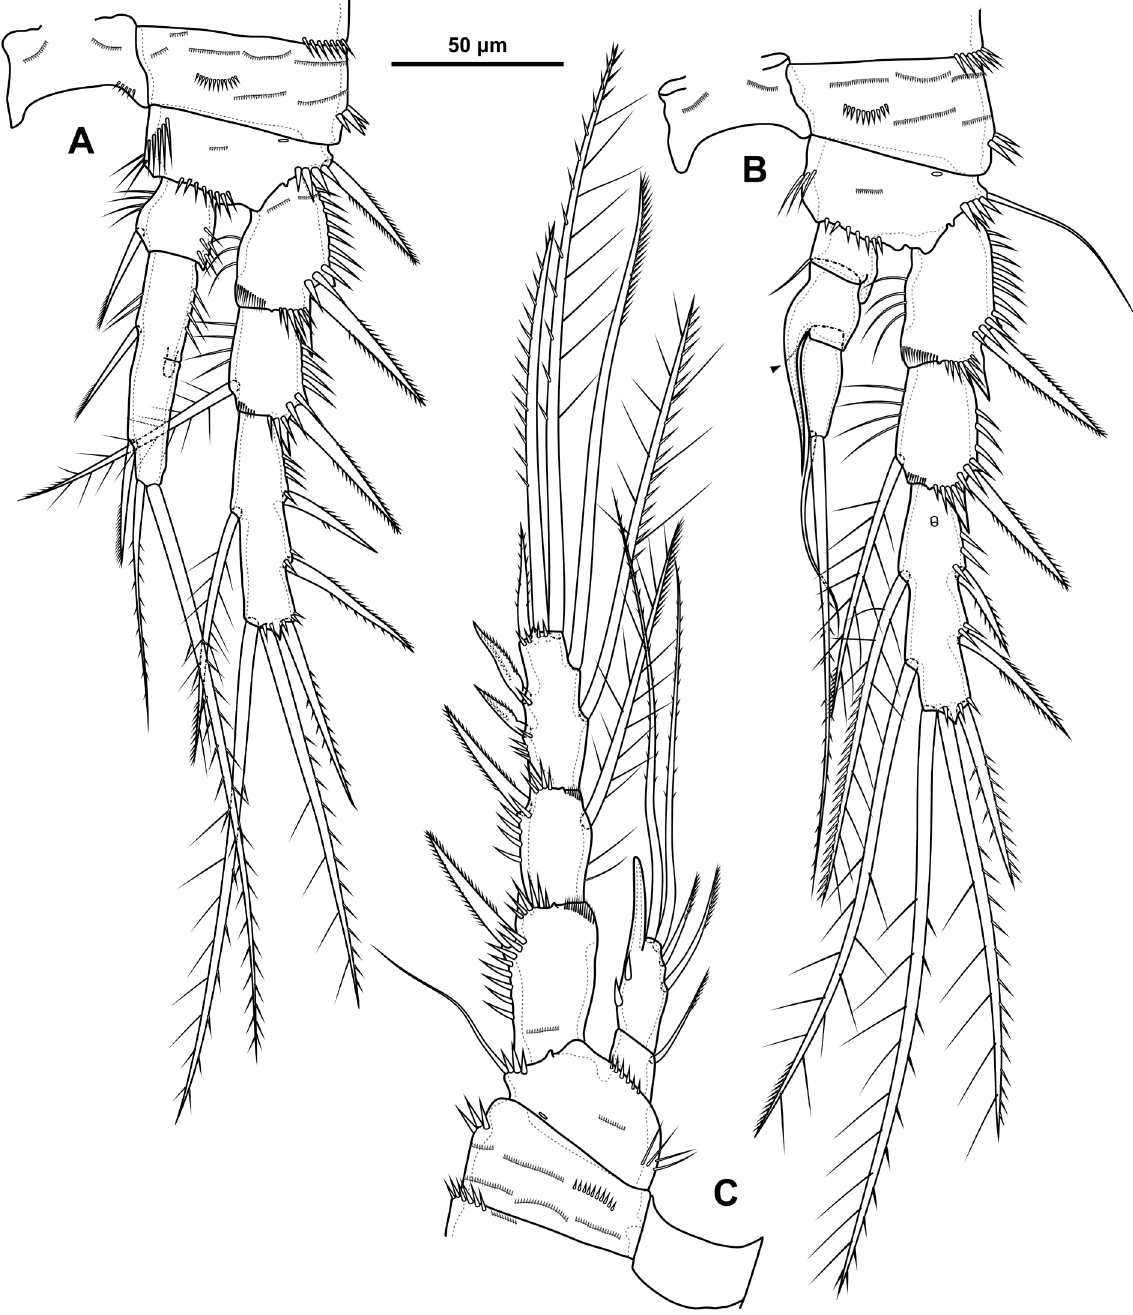
Fig. 9. Canthocamptus waldemarschneideri sp. nov., allotype, ♂ (KFU BP 544/2). A . P2. B . P3; small seta indicated by arrowhead. C .